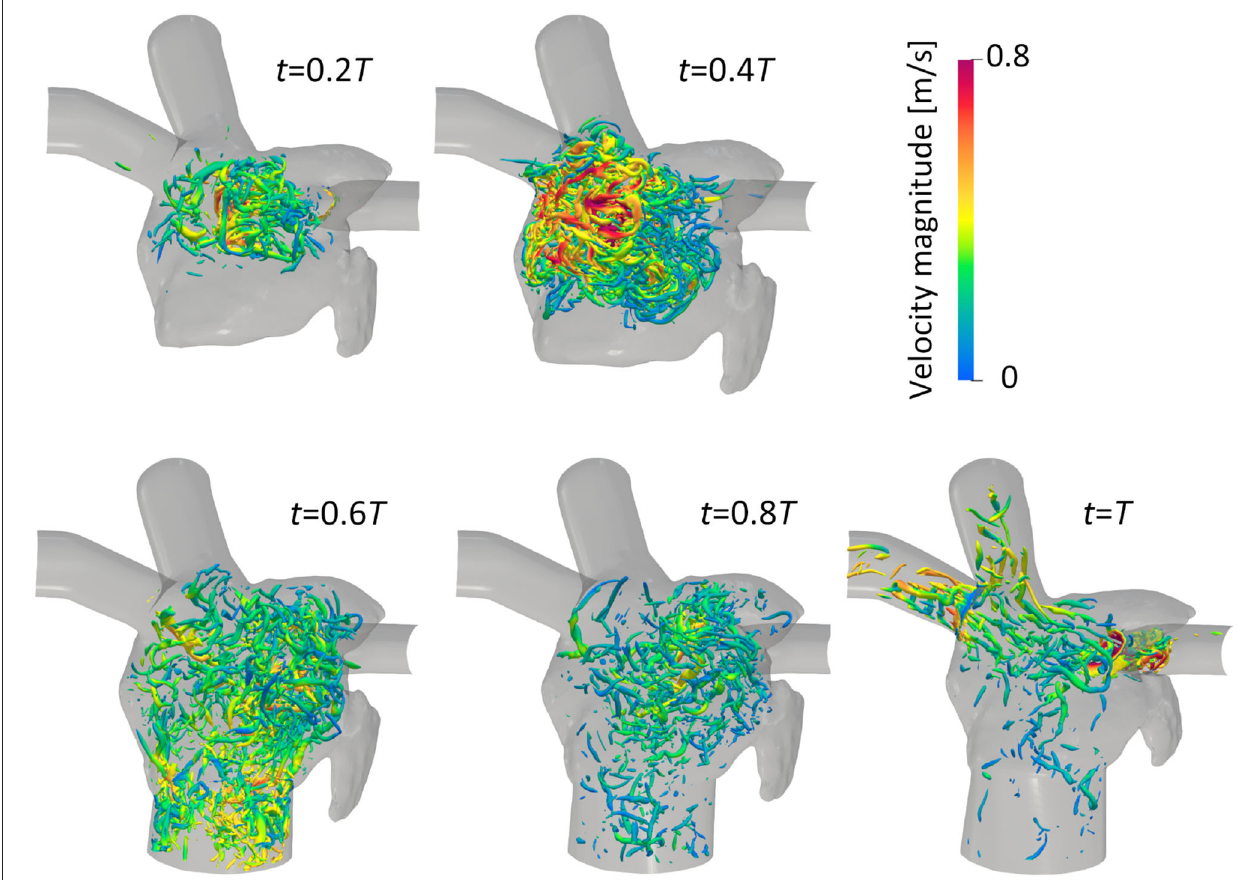
FIGURE 6 | Anterior views of vortex iso-surfaces identified using the λ 2 criterion ( λ 2 = − 0.01 ms 2 ) at t = 0.2 T , 0.4 T , 0.6 T , 0.8 T , and T after the left upper lobectomy ( T : cardiac cycle from the start of systole). Contour plots show the velocity